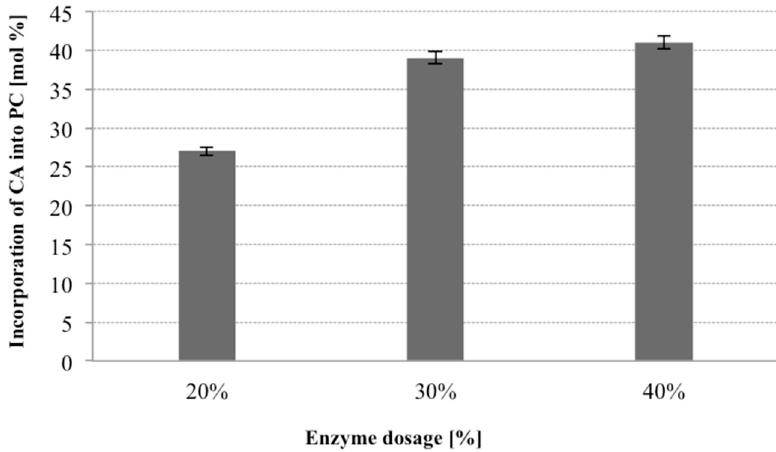
Figure 5. Effect of enzyme load on the incorporation of CA into egg-yolk PC in acidolysis reaction (reaction conditions: PC 30 mg, 1:60 PC/CA molar ratio, toluene 2 mL, temperature 30 °C, enzyme load 20/30/40% ( w / w ) Novozym 435, time 48 h).